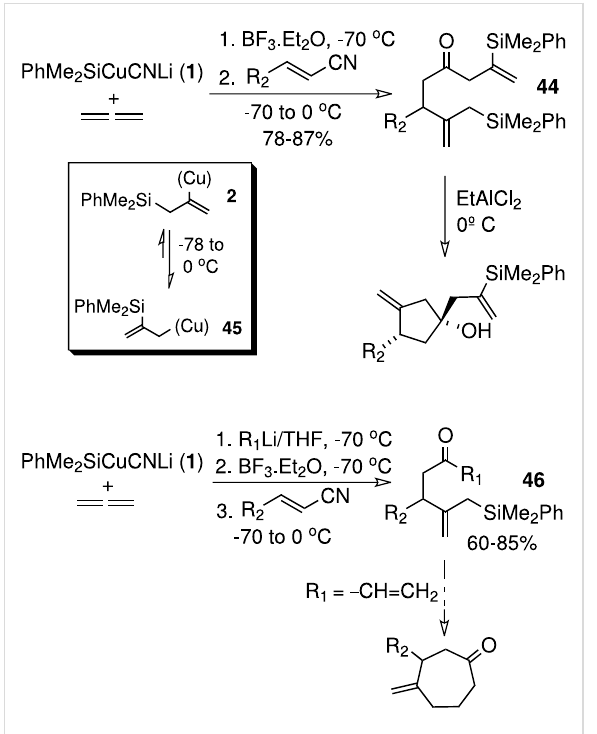
Scheme 12: Seven membered ring formation from functionalized